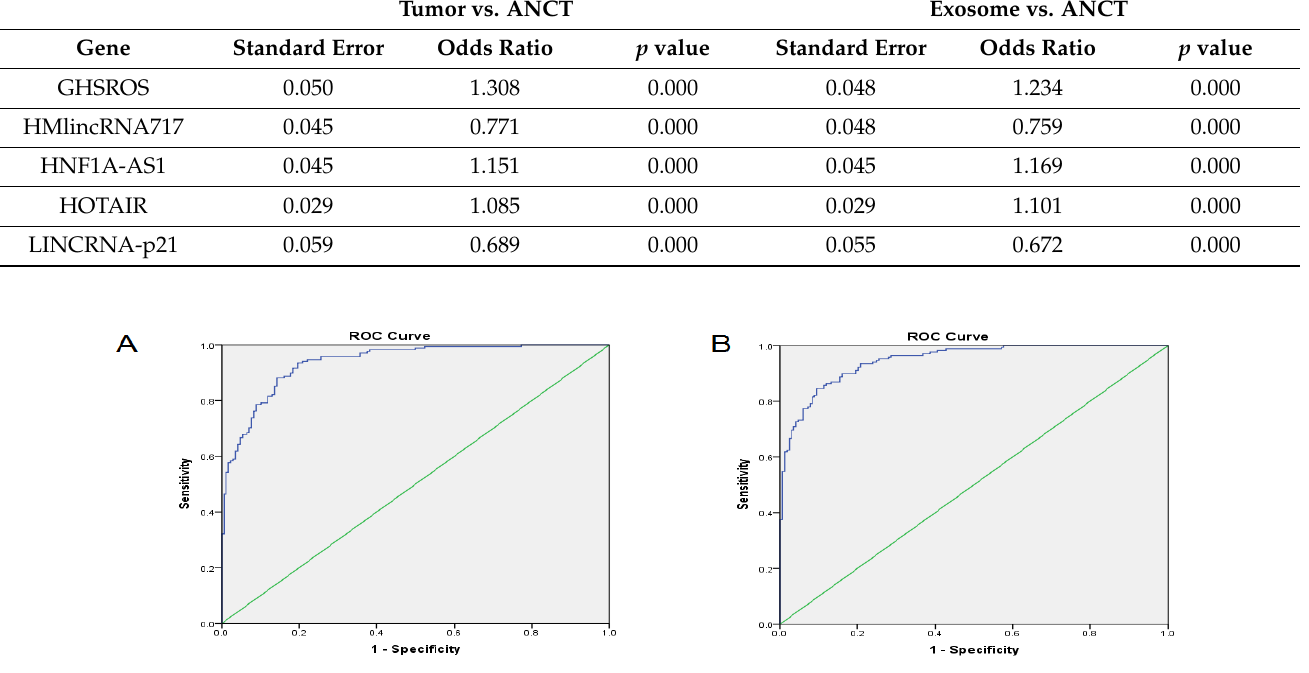
Figure 4. The ROC curve analysis results. ( A ): The area under the curve (AUC) for the expression of a panel of 5 lnc-RNAs in tumor and normal tissue. ( B ): The AUC for the expression of a panel of 5 lnc-RNAs in exosome and normal tissue. Table 4. Binary regression model results.